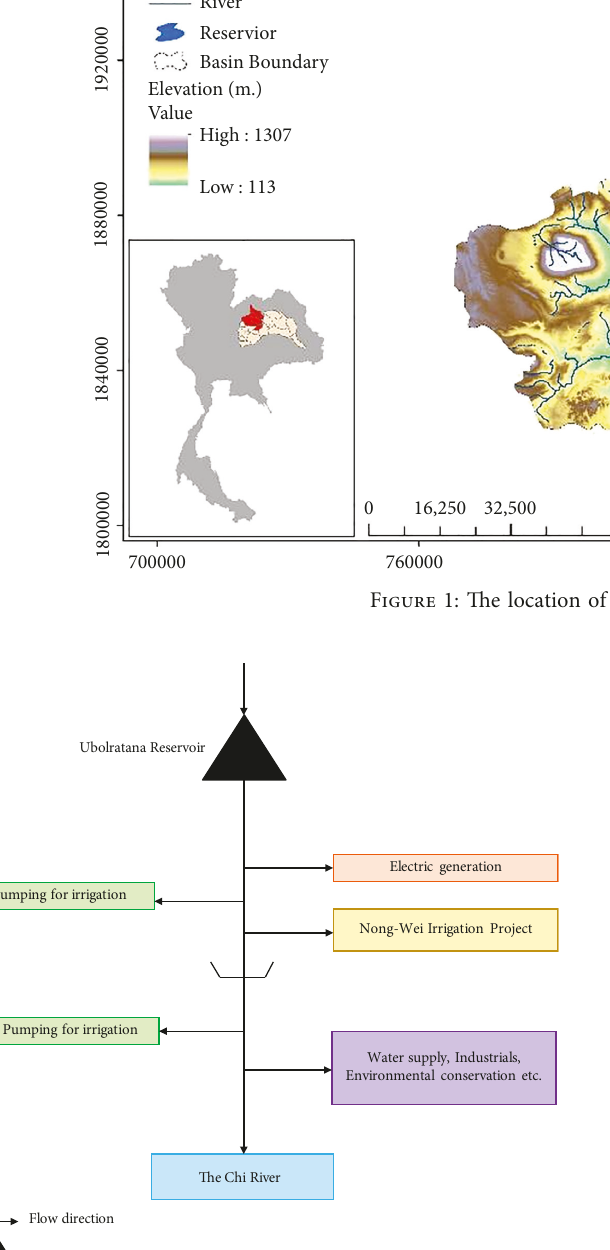
Figure 2: Schematic diagram of the Ubolratana